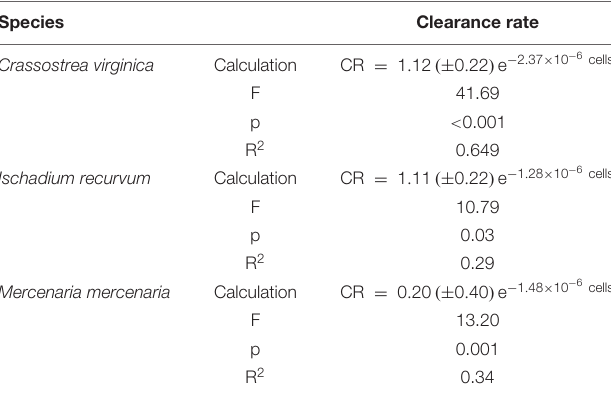
The negative sign after the e indicates that all regressions are negative.p indicates significance; the adjusted regression coefficient is indicated by R 2 . Asterisks denote significant p-values (p <